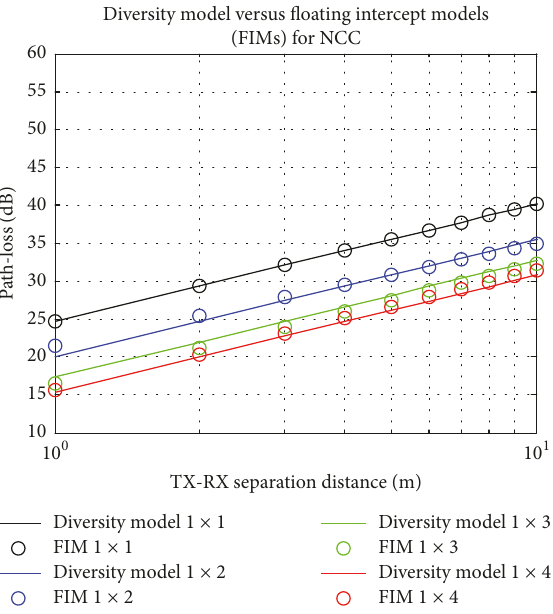
Figure 18: Path-loss for the proposed floating intercept-based diversity model given by (6) for the CC scheme when considering NLOS scenario, with 𝛼 SISO = 31.36 , 𝛽 SISO = 1.53 , and 𝐵 = 0.276